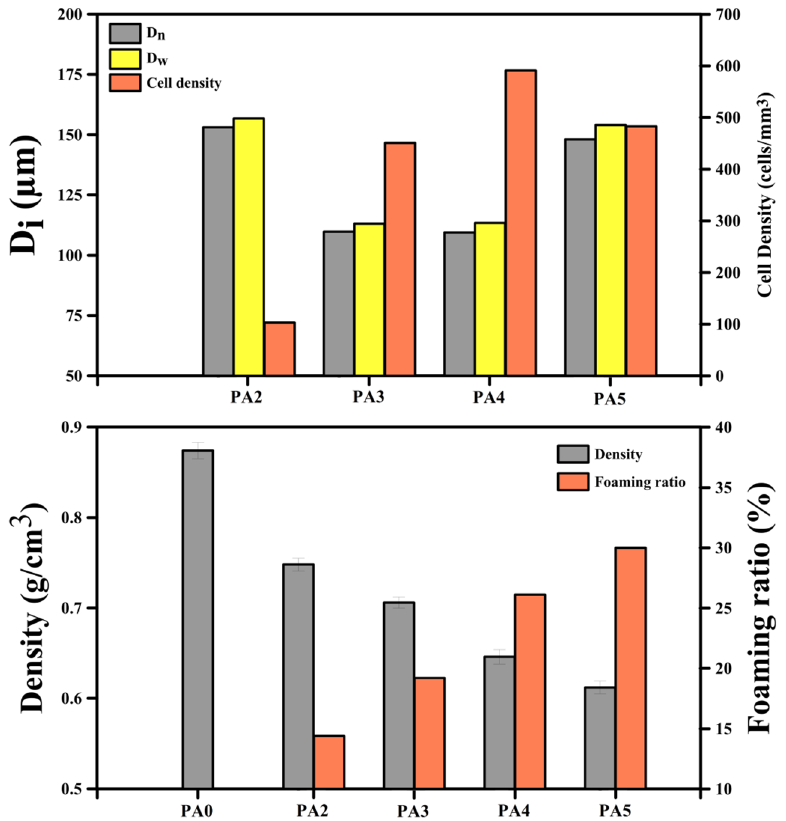
Figure 2. Morphological and physical characteristics of POE foams with different ADC contents.